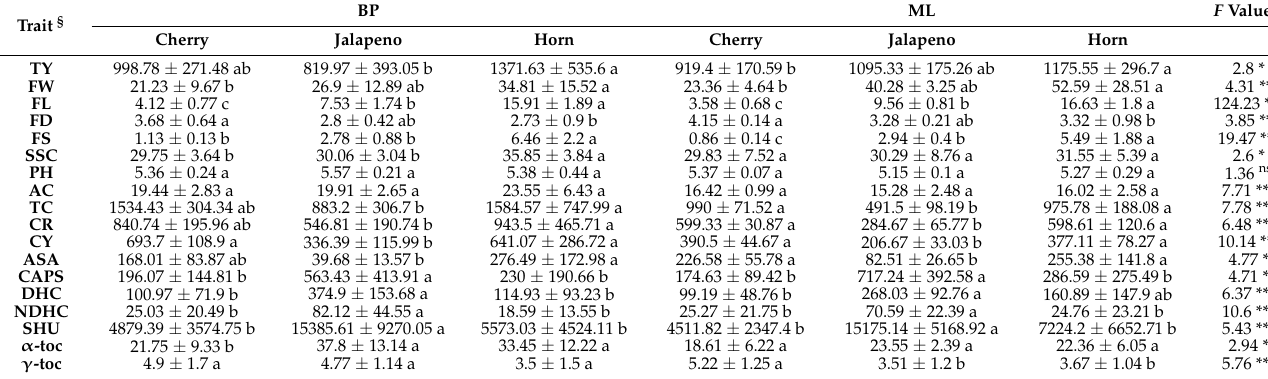
§ Acronym’s description is in the method section. TY is expressed in g per plant; FW is expressed in g per fruit; FL and FD are expressed in cm; SSC is expressed as ◦ Bx dw; AC is expressed as mEq% dw; TC, CR, CY, CAPS, DHC, NDHC are expressed as mg/kg dw; AsA, γ